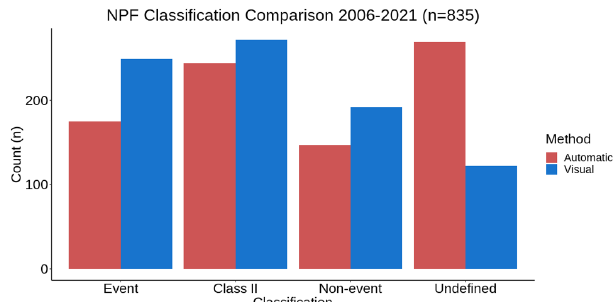
Figure 6. Comparisons detailing the number of days considered a given classification category between the automatic classification method (red) and visual classification (blue). The event category includes type 1a and type 1b